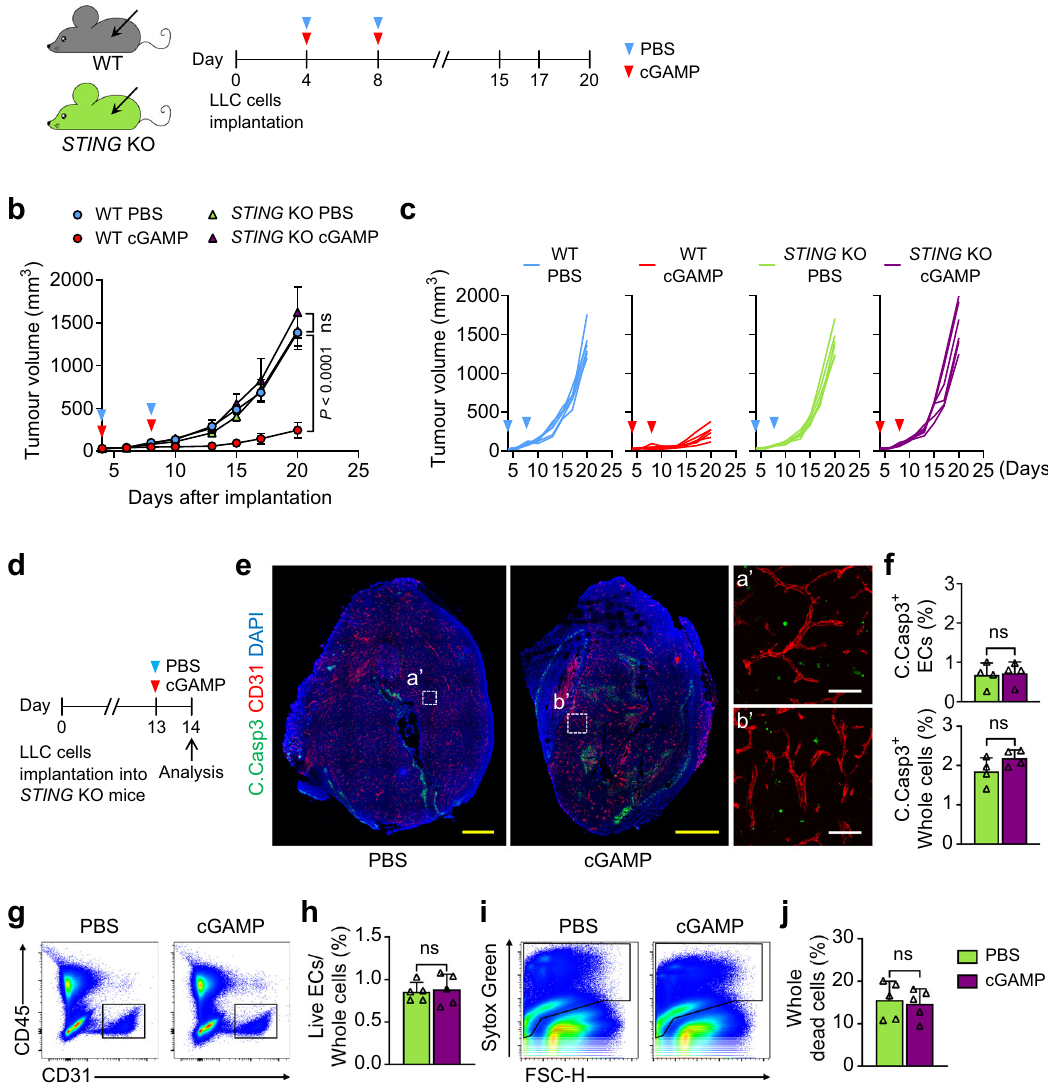
Fig. 2 cGAMP-induced tumour EC apoptosis is abrogated in STING KO mice. a – c Diagram depicting generation of implanted LLC tumour and treatment schedule of i.t. PBS or cGAMP in WT and STING KO mice. Comparison of LLC tumour growths. n = 6 mice/group from three independent experiments. Dots and bars indicate mean ± SD. Plot indicates each individual tumour growth. P values by Welch ’ s one-way ANOVA test followed by Dunnett ’ s T3 test. ns, not signi fi cant. d – j Diagram depicting generation of implanted LLC tumour in STING KO mice, i.t. PBS or cGAMP treatment, and sampling of tumours at 24 h later. Representative images and comparisons of apoptosis in tumours EC and whole tumour cells (whole cells). Each dotted-line box region is magni fi ed and displayed in the right panels. Scale bars, 1.0 mm (yellow) and 100 μ m (white). Each dot indicates a value from one mouse and n = 4 mice/ group from two independent experiments ( f ). Representative fl ow cytometry plots and comparisons of populations of live ECs and dead cells in whole tumour cells. Each dot indicates a value from one mouse and n = 5 mice from two independent experiments ( h , j ). Vertical bars indicate mean ± SD. P values by two-tailed t-test. ns, not signi fi cant. Source data are provided as a Source Data fi